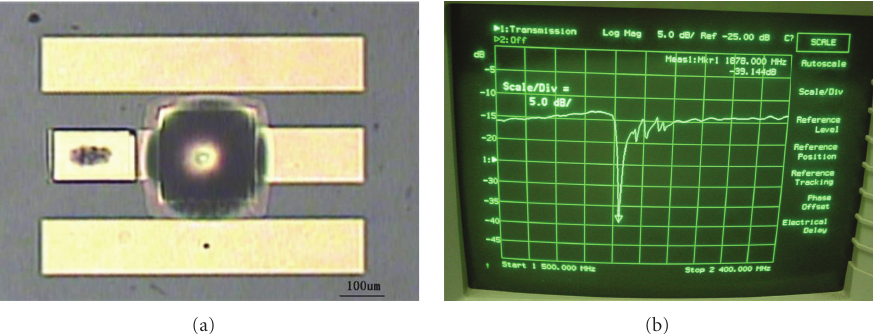
Figure 3: (a) Chip photo of the fabricated FBAR, (b) measured resonant frequency of FBAR.